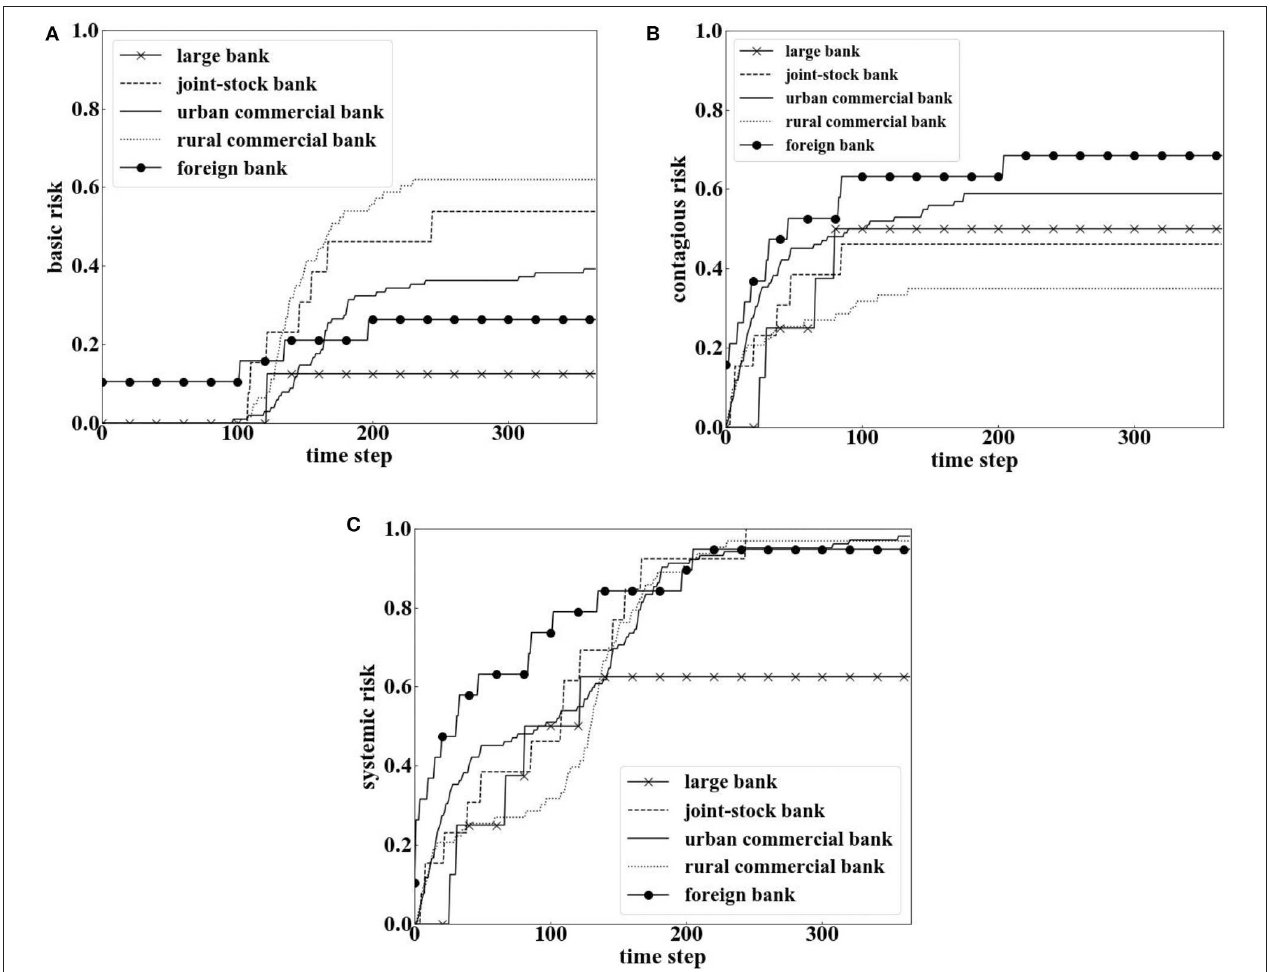
FIGURE 8 | Basic risk, contagious risk, and systemic risk evolution curve of different types of Chinese banks.